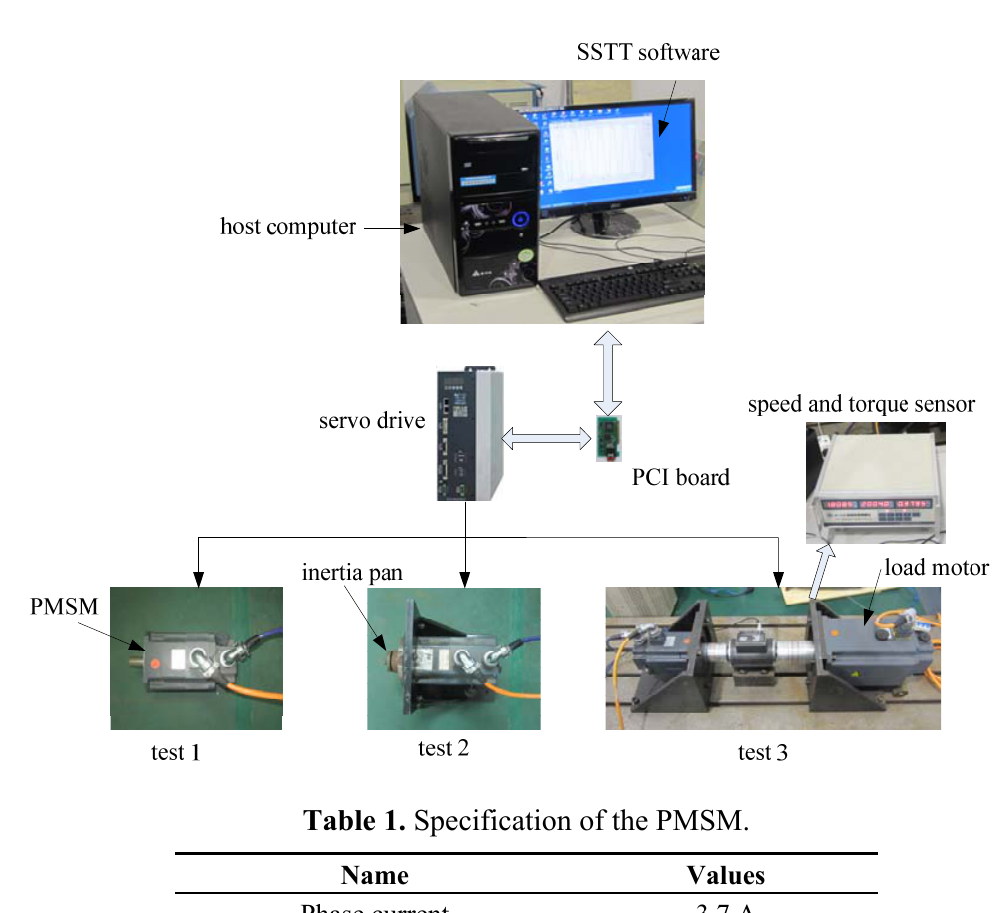
Figure 5. The apparatus for the experimental platform.